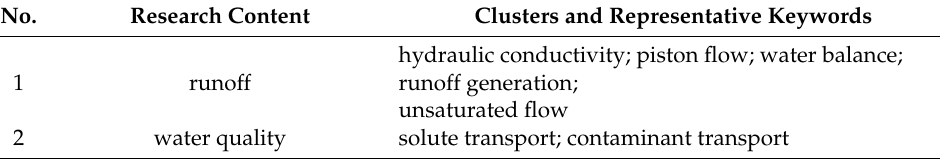
Table 6. Two categories of